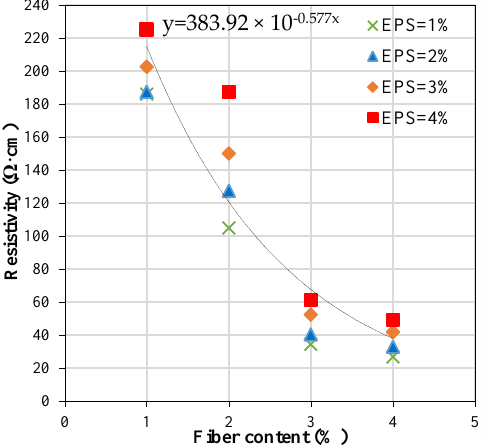
Figure 4. The variation of resistivity with the increasing fiber content with curing period of seven days.